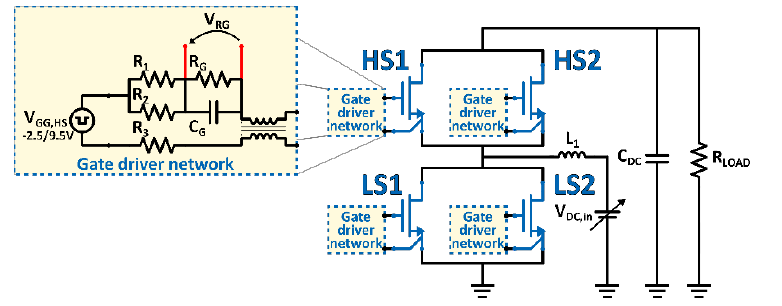
Figure 10. Circuit schematic of the synchronous step-up converter based on Ohmic-gate p-GaN HEMTs and of the gate driver.